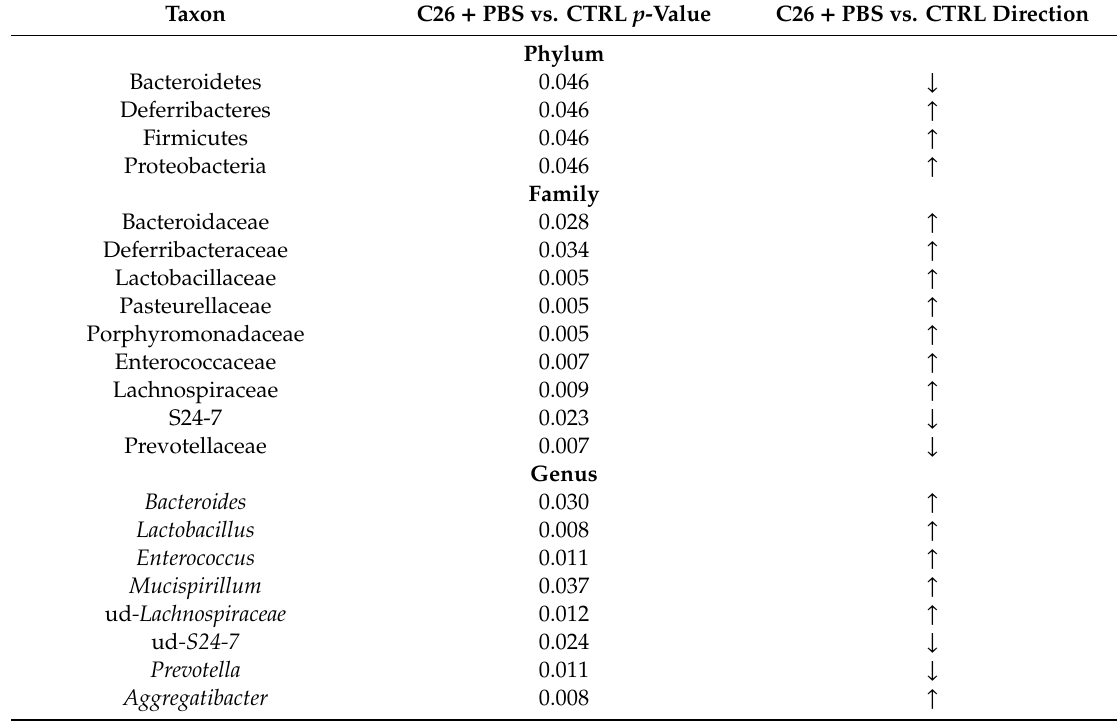
Table 1. The statistically significant di ff erences and the direction of the change in the taxa between the C26 + PBS and CTRL